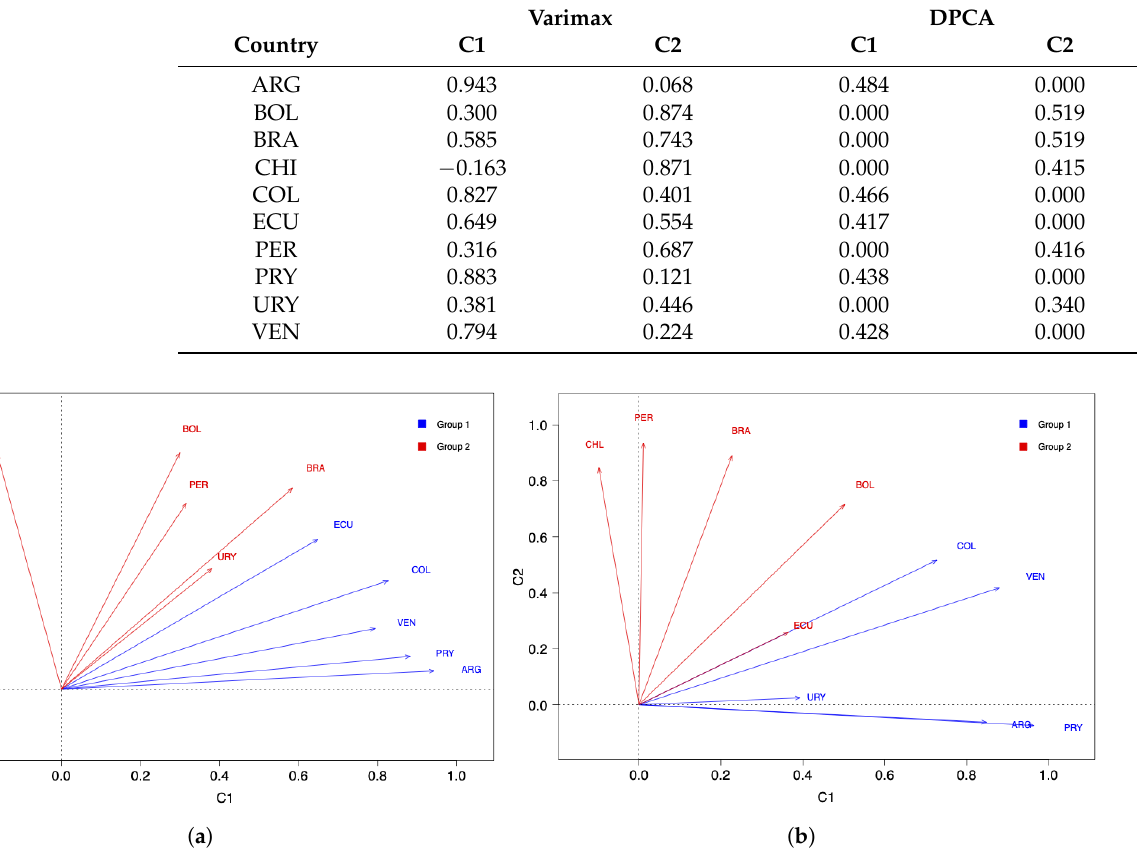
Figure 1. Space of countries for data of the number of COVID-19 ( a ) infected cases and ( b )